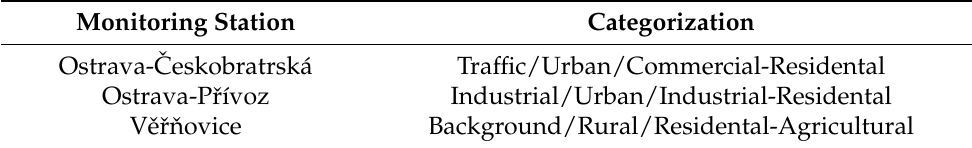
Table 1. Categorization of monitoring stations.